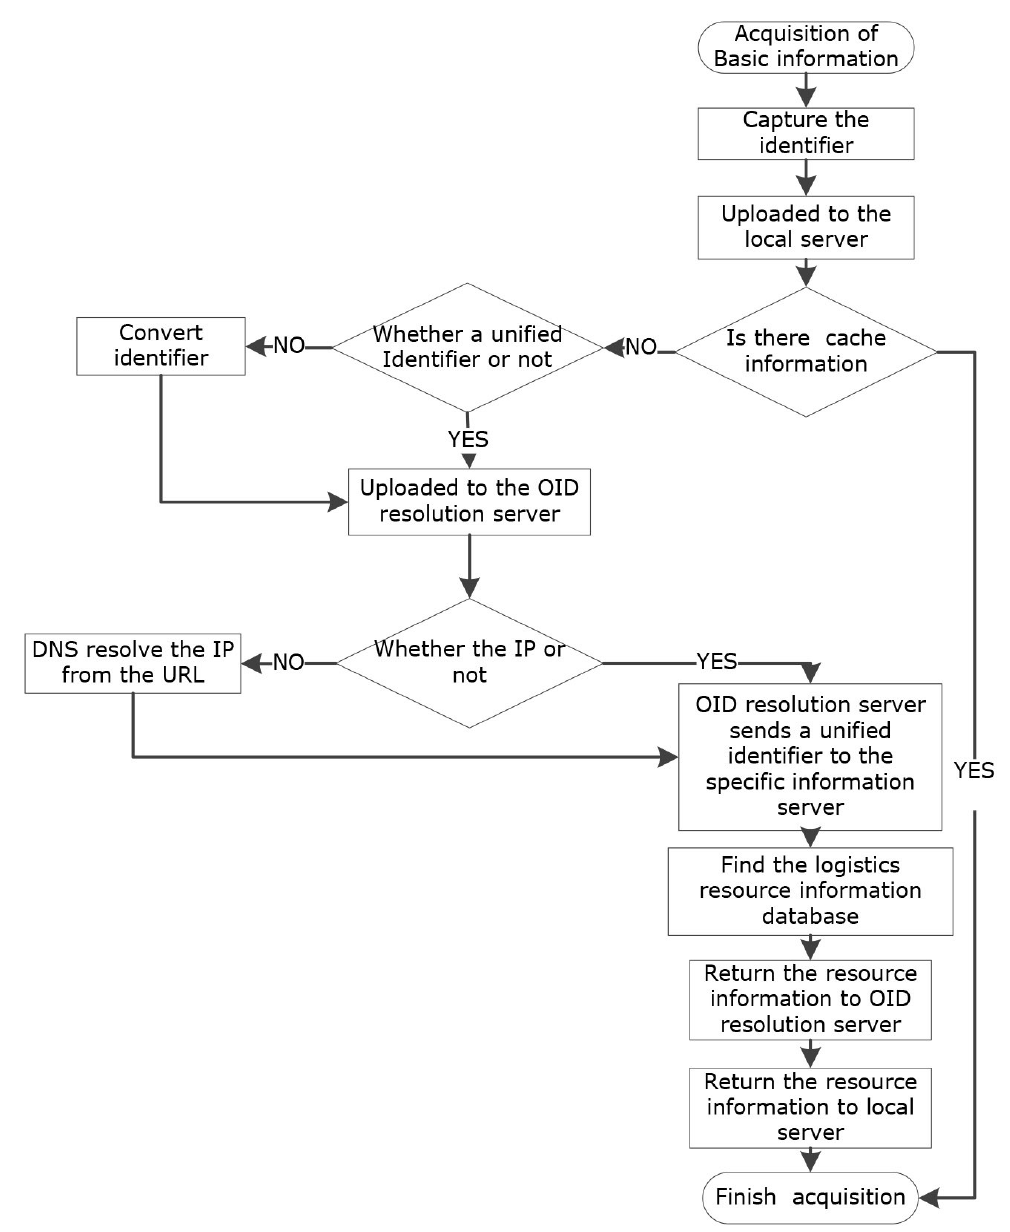
Figure 5. Flow Chart of Accessing to Logistics Resources Basic